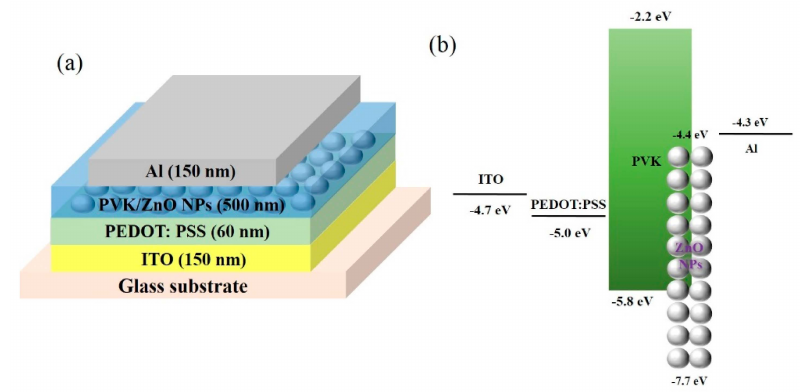
Figure 1. Schematic diagram of the fabricated UV photodetector based on the HPL of PVK/ZnO NPs: ( a ) device structure and ( b ) bandgap diagram.